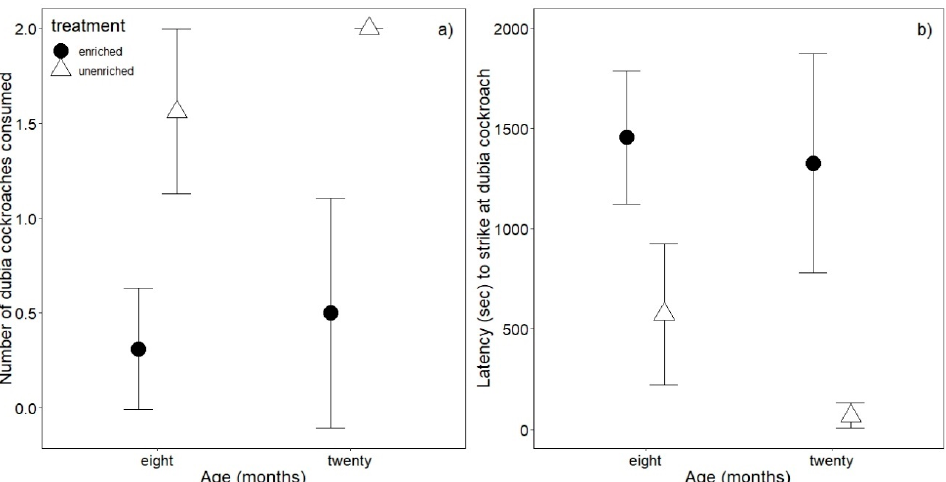
Figure 4. Number of dubia cockroaches ( Blaptica dubia ) consumed ( a ) and latency to strike at a cockroach ( b ) by enriched and unenriched eastern box turtles ( Terrapene carolina ) when eight or 20 months old. Symbols represent means and bars are 95% confidence intervals. There is no confidence interval for twenty-month-old unenriched turtles in panel ( a ) because all these turtles consumed both cockroaches.